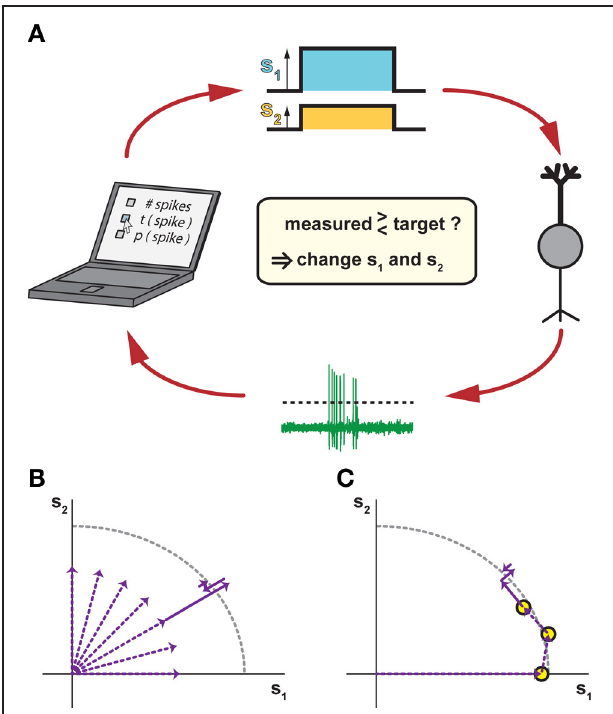
FIGURE 2 | Closed-loop methods for measuring iso-response stimuli. (A) Closing the loop by tuning stimulus parameters according to measured responses. In response to a stimulus with two components s 1 and s 2 (top), a recorded neuron (right) responds with spikes that are automatically detected, for example by a threshold criterion (bottom). The spike response is then compared to a chosen target criterion (left), which may be the number of spikes, the timing of the first spike, the probability of spiking, or any other accessible response feature. According to this comparison, the values of s 1 and s 2 are adjusted for the next stimulus presentation in order to approach the target response. (B) Potential search strategy in radial directions of the stimulus space. This combines several linear searches, which can be performed sequentially or interleaved, typically starting near the origin so that overly strong stimulation is avoided. (C) Potential search strategy by tracking iso-response curves. Here, previously measured iso-response stimuli are used as starting conditions for searching nearby stimuli that yield the same response. This can be done, for example, by changing the ratio of s 1 and s 2 while keeping the same radial distance as for a previously measured iso-response stimulus and then tuning this radial distance until the desired response is obtained. As compared to the strategy of pure radial searches in (B) , this sequential search can provide higher recording efficiency, but does not allow interleaving multiple